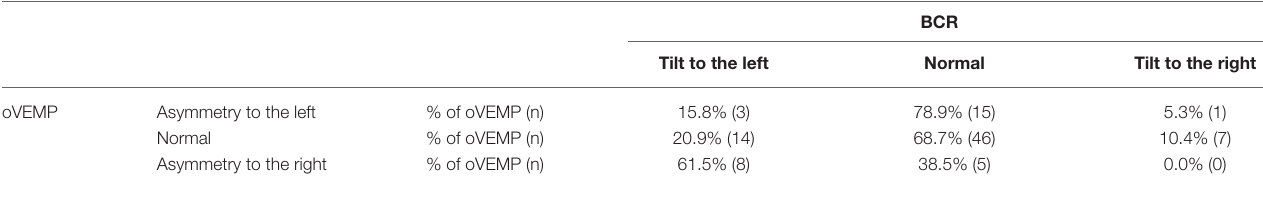
TABLE 3 | Cross table of oVEMP and